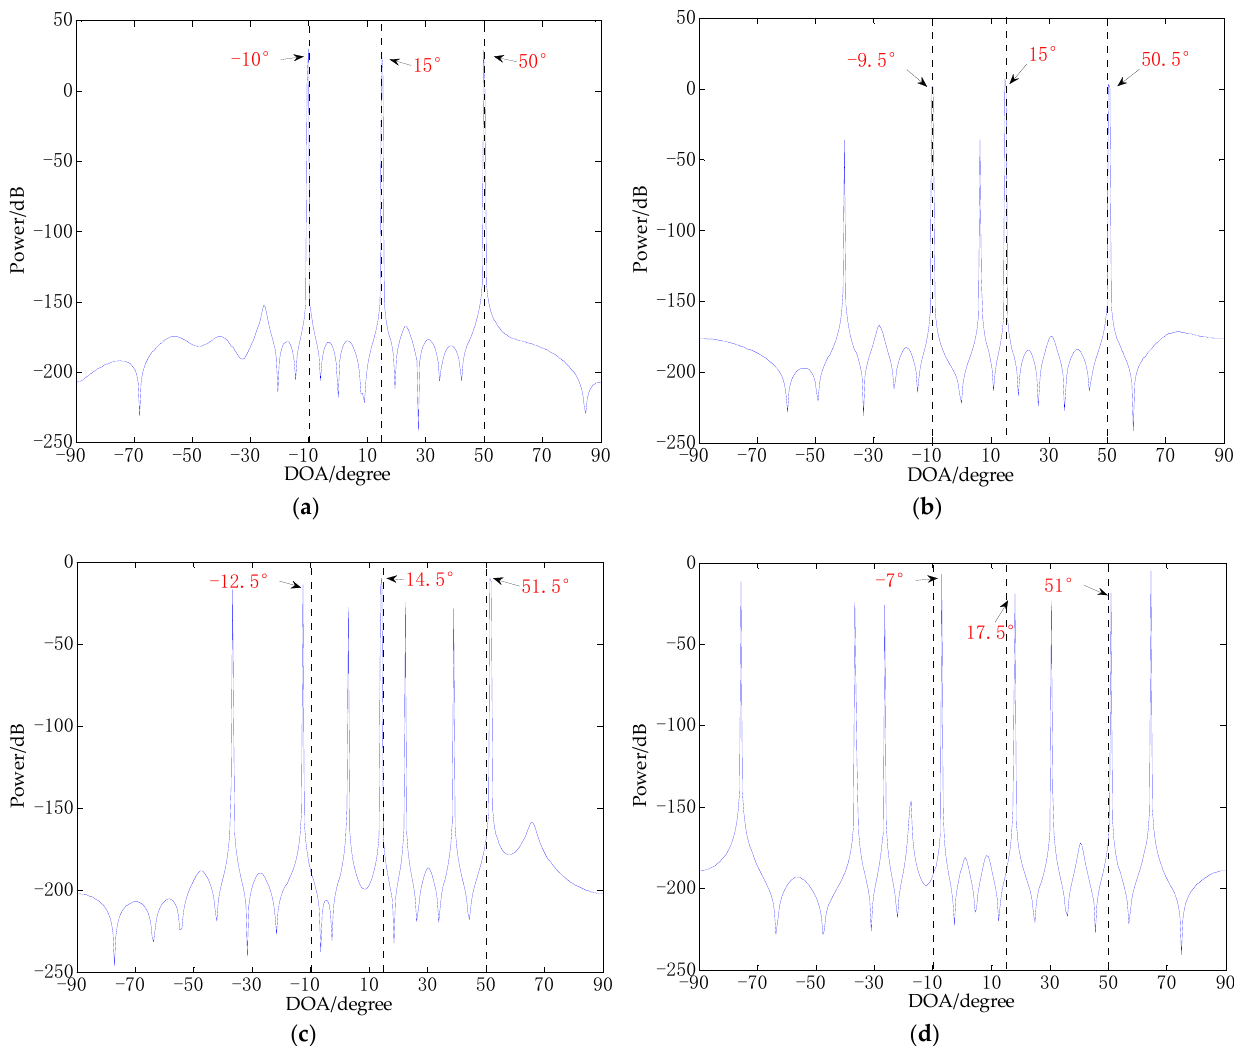
Figure 2. CS-DOA experiment under the same regularization parameter and different SNR. ( a ) SNR = 30 dB; ( b ) SNR = 10 dB; ( c ) SNR = − 5 dB; ( d ) SNR = − 10 dB.